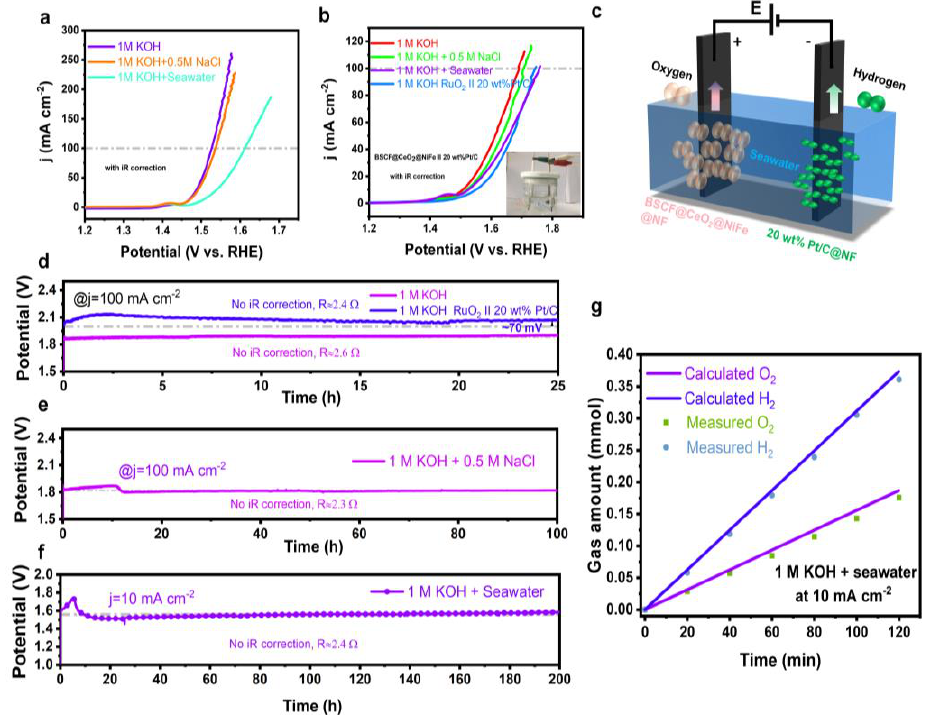
Figure 3. ( a ) OER LSV curves of BSCF@CeO 2 @NiFe and ( b ) polarization curves of overall water splitting with BSCF@CeO 2 @NiFe anode in 1 M KOH (and RuO 2 ), 1 M KOH + 0.5 M NaCl, and 1 M KOH + seawater. Insert of ( b ) is the illustration of overall water splitting. ( c ) Schematics of overall seawater splitting. ( d ) Stabilities of BSCF@CeO 2 @NiFe and RuO 2 anodes for overall water splitting in 1 M KOH, ( e ) 1 M KOH + 0.5 M NaCl, and ( f ) 1 M KOH + seawater. ( g ) Faradaic efficiency measurement in 1 M KOH + seawater at 10 mA cm −2 .